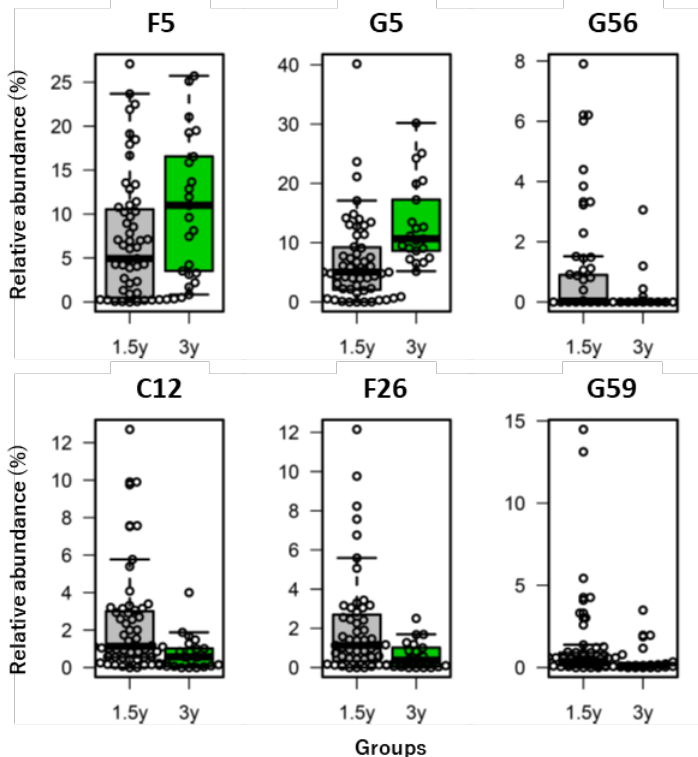
Figure 8. Box plots of the bacteria listed in Table 5 that showed significant different relative abun- dances between the two age groups (1.5 years and 3 years). The depicted bacteria are those whose abundance differences between Methods A–C were within the limits of agreement in all the specimens (See Table 5). Bold lines in the middle of the box are the medians, the top of the box is the 3rd quartile, the bottom of the box is the 1st quartile, the upper whiskers are the largest data less than or equal to “3rd quartile + 1.5 × (3rd quartile − 1st quartile)” and the lower whiskers are the smallest data equal to “1st quartile − 1.5 × (3rd quartile − 1st quartile)”. See Tables S1–S6 for the bacterial taxonomy name corresponding to each ID.